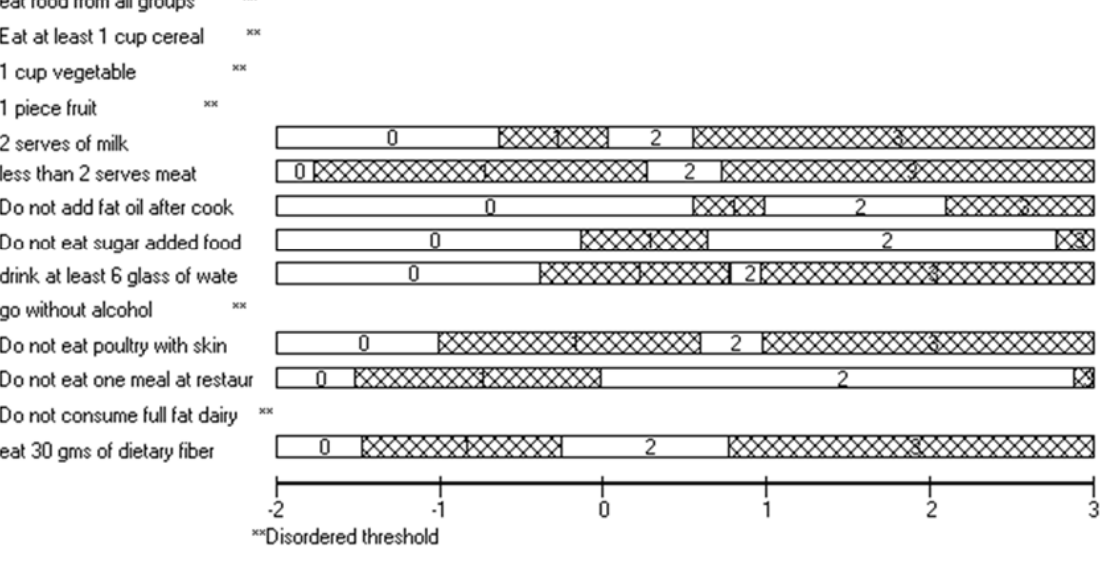
Figure 1. Threshold map for all items.